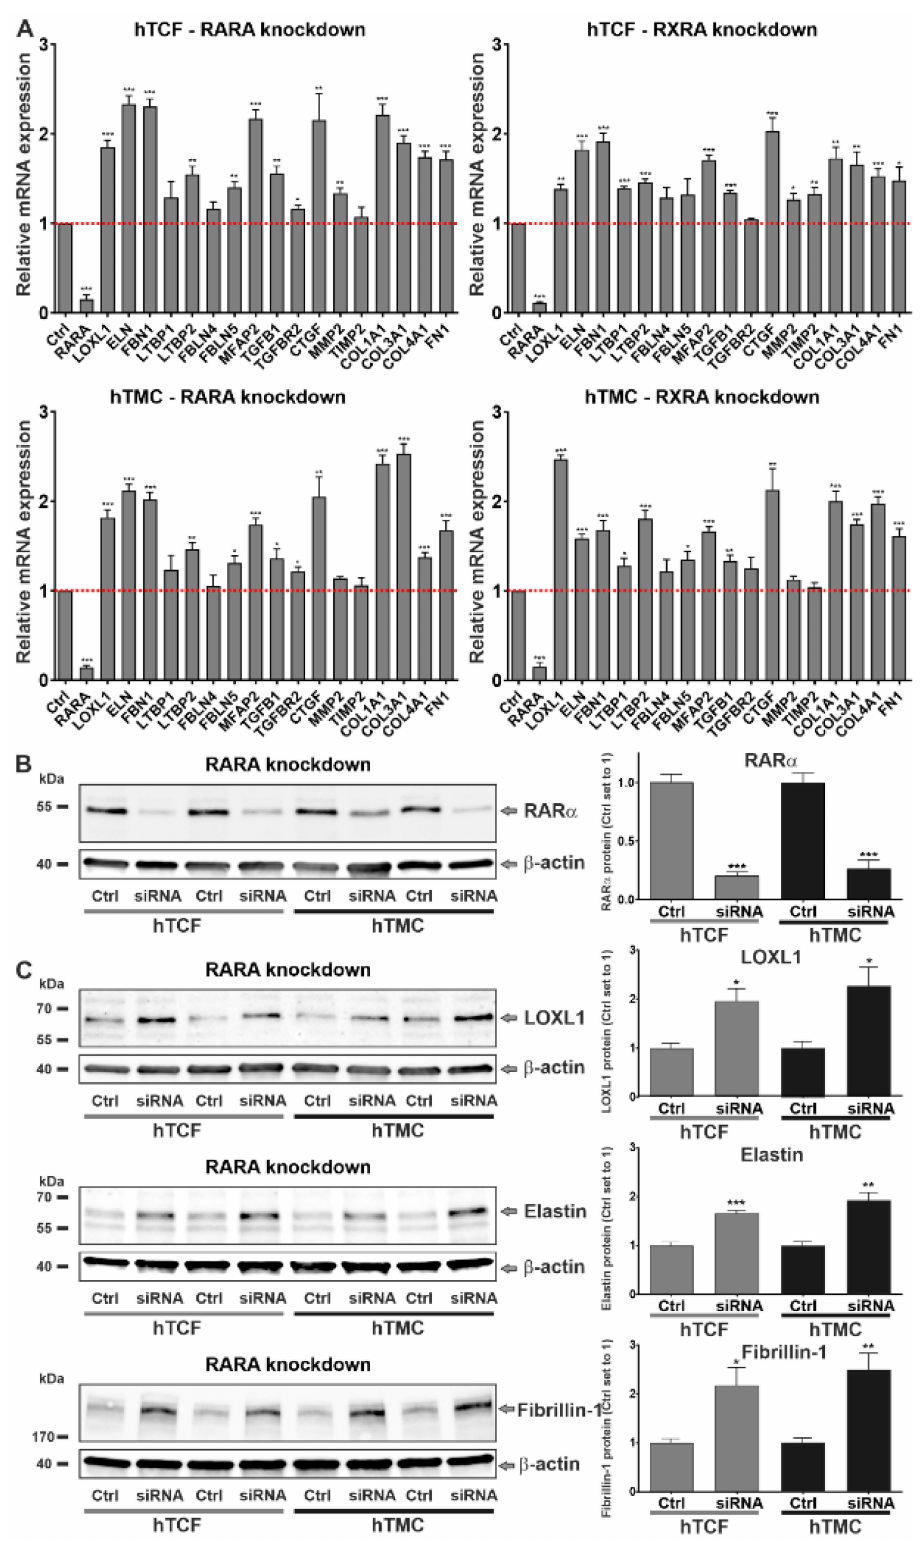
Figure 5. Effects of RARA (retinoic acid receptor alpha) and RXRA (retinoid X receptor alpha) knockdown on matrix synthesis in PEX-relevant cell types. ( A ) Quantitative real-time PCR analysis of RARA , RXRA , LOXL1 (lysyl oxidase-like 1) , ELN (elastin), FBN1 (fibrillin-1), LTBP1 (latent transforming growth factor beta binding protein 1), LTBP2 , FBLN4 (fibulin-4), FBLN5 , MFAP2 (microfibril